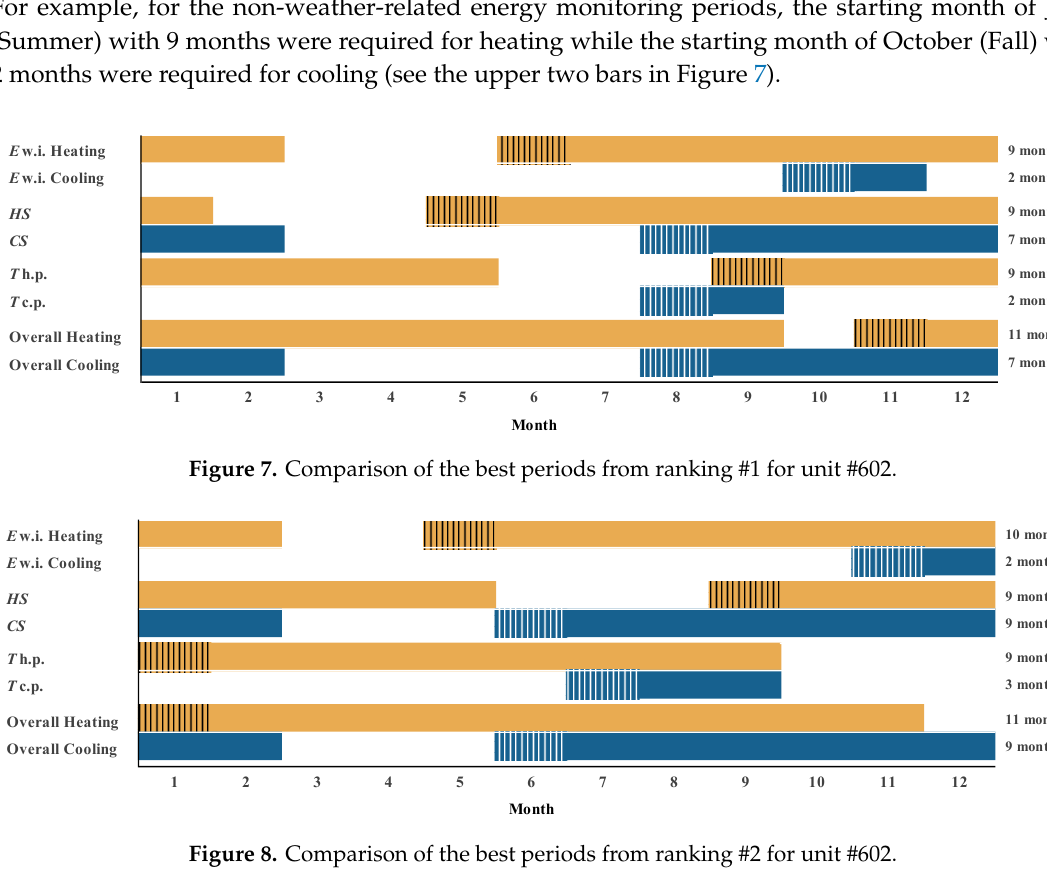
Figure 9. Comparison of the best periods from ranking #3 for unit #602. The discontinued spaces where the bars are not presented on the x -axis show the months when it is not necessary to measure heating or cooling energy use performance. In other words, monitoring costs can be saved because monitoring is not needed during these months. Unfortunately, when both the heating and cooling loads’ interval data were considered, all 12 months were required to analyze